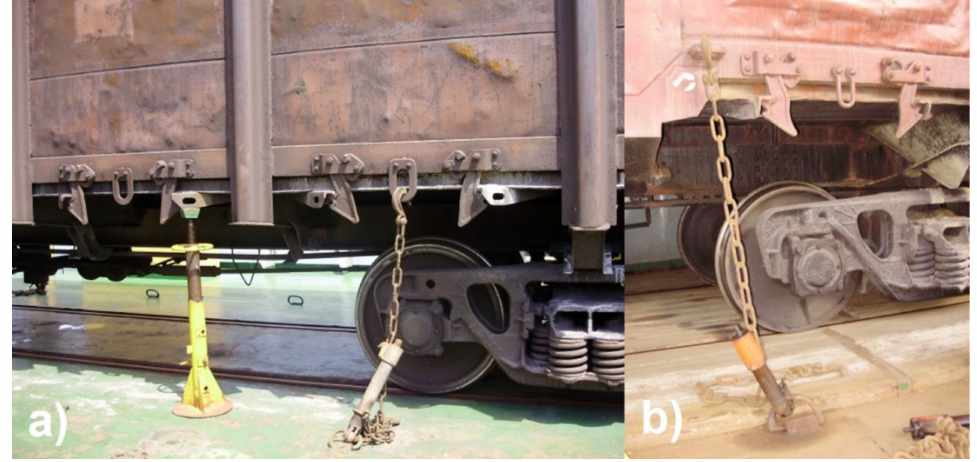
Figure 3. Securing of a rail car on the train ferry deck ( a ) Geroi Plevny; ( b )